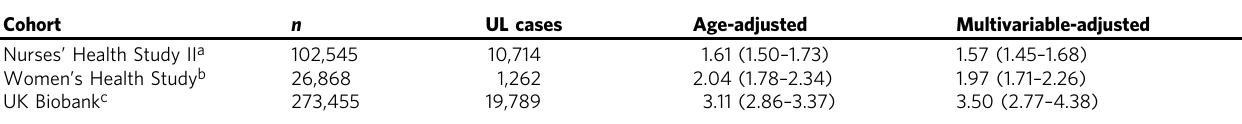
Table 2 Multivariable-adjusted effect estimates of the association between endometriosis and UL among women in NHSII, WHS, and UKBB cohorts Cohort